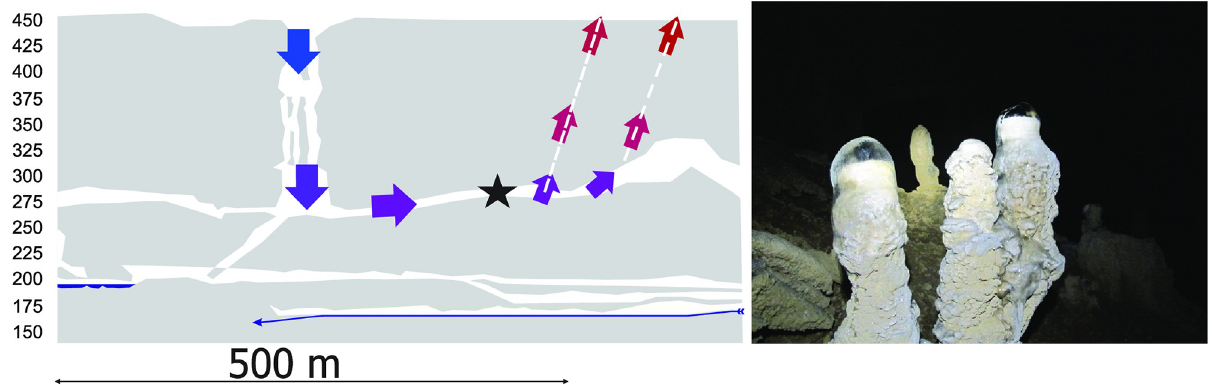
Fig 15. Left: A simplified profile of part of the Ka č na Cave (Slovenia). Arrows show winter airflow direction and air temperature on a red (warm) to blue (cold) colour scheme. Dashed lines indicate unexplored airflow pathways. Right: photograph of ice formation on the stalagmites taken during cold period in February 2012. The approximate position of stalagmites is indicated by a black star in the profile.